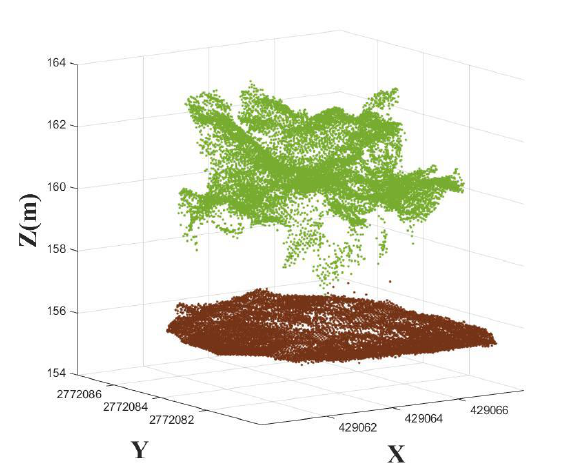
Figure 6 . The results of point cloud